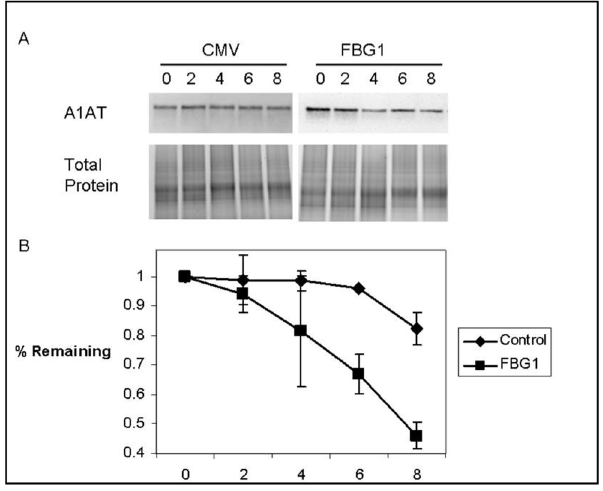
Fig 7. FBG1 decreases A1AT-Z half-life. A) Hepa1-6 cells transfected with A1AT-Z and CMV or FBG1. After cycloheximide treatment, cells were harvested every 2 hours. Cells were lysed, separated on SDS-PAGE gels and probed with anti-A1AT. Shown is representative gel. B) Densitometry of westerns in “ A ” using ImageJ, normalized to total protein (n =